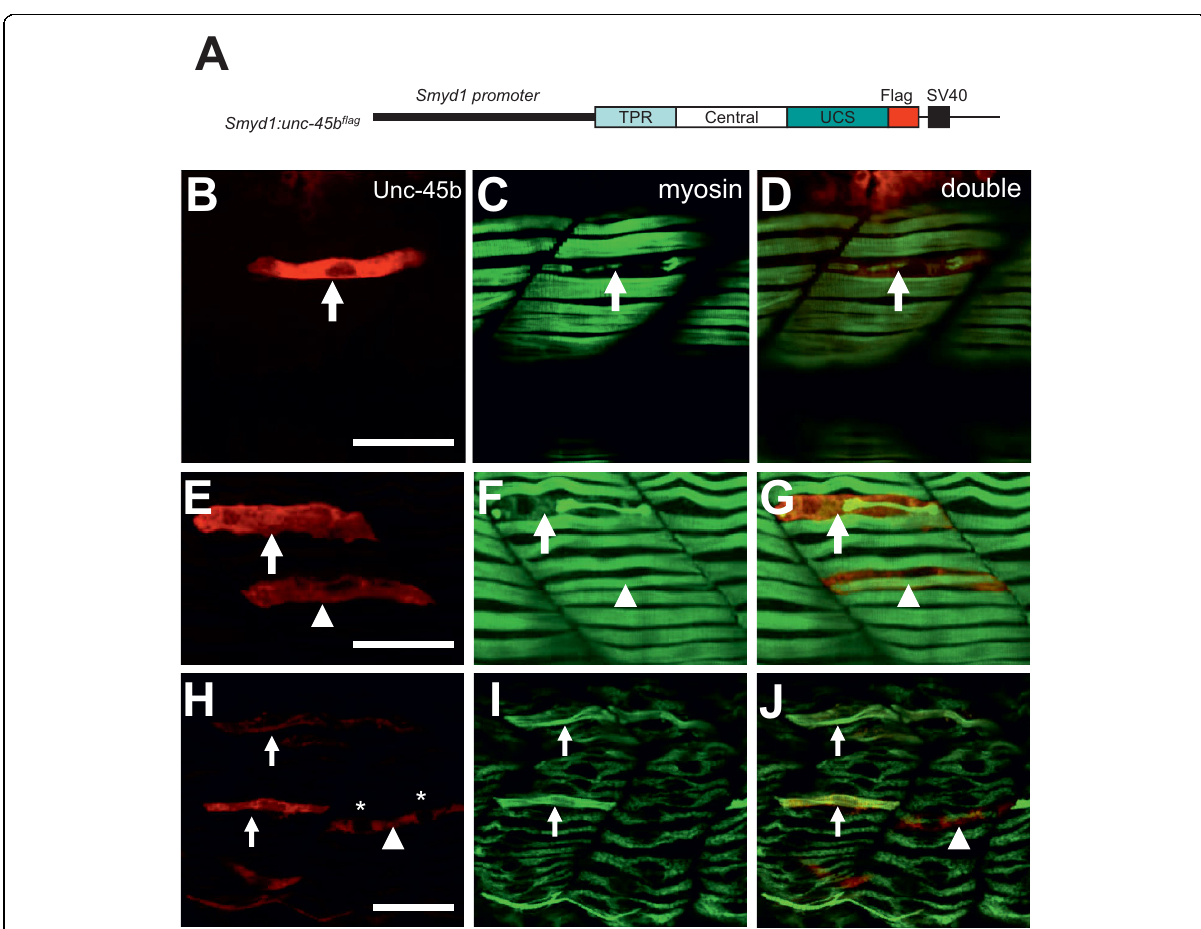
Figure 4 Overexpression of Unc-45b resulted in defective thick filament organization . A. The DNA construct expressing a flag-tagged Unc-45b under the control of smyd1 promoter was injected into zebrafish embryos. The effect on thick filament organization was analyzed by double antibody staining at 30 hpf. B-D . Double staining with anti-flag (red) and anti-myosin (F59, green) antibodies shows the expression of flag-tagged Unc-45b (B) in a single fiber and its effect on myosin thick filament organization (C). D represents the merged image of B and C showing that the myofibril defect is restricted to the myofiber expressing the flag-tagged Unc-45b. Fifty six myofibers from 40 embryos were analyzed. 70% of the myofiber showed the disorganized thick filaments. E-G . Double staining shows the expression of flag-tagged Unc-45b in two myofiber with different phenotypes on myosin thick filament organization. One myofiber exhibited disorganized thick filament (Arrow). In contrast, another myofiber exhibited normal thick filament organization (arrow head). However, this fiber appeared to be skinnier compared with its neighbors without the ectopic Unc-45b expression. H-J . Double staining shows the rescue of thick filament organization in Unc45b knockdown zebrafish embryos co-injected Unc45b-MO with the smyd1:unc45b flag DNA construct. Myofibers expressing the flag-tagged Unc45b (H) exhibited normal thick filament organization (I, J). The fast fiber with two nuclei (*) is indicated by the arrow head. F59 does not label myosin expressed in fast muscles. Thirty five slow myofibers from 29 embryos were analyzed. 100% of the slow myofiber expressing the flag-tagged Unc45b (H) exhibited normal thick filament organization. Scale bars = 15 μ